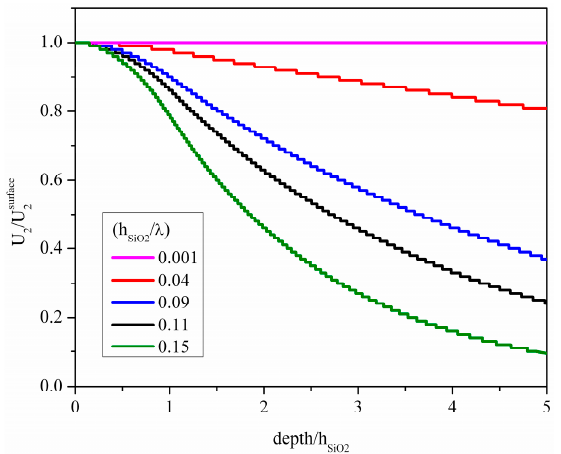
Figure 4. The normalized particle displacement component of the Love wave vs . the acoustic wave penetration depth normalized to the SiO 2 layer thickness h SiO2 ; the SiO 2 thickness to wavelength ratio, h SiO2 / λ , is the running parameter.